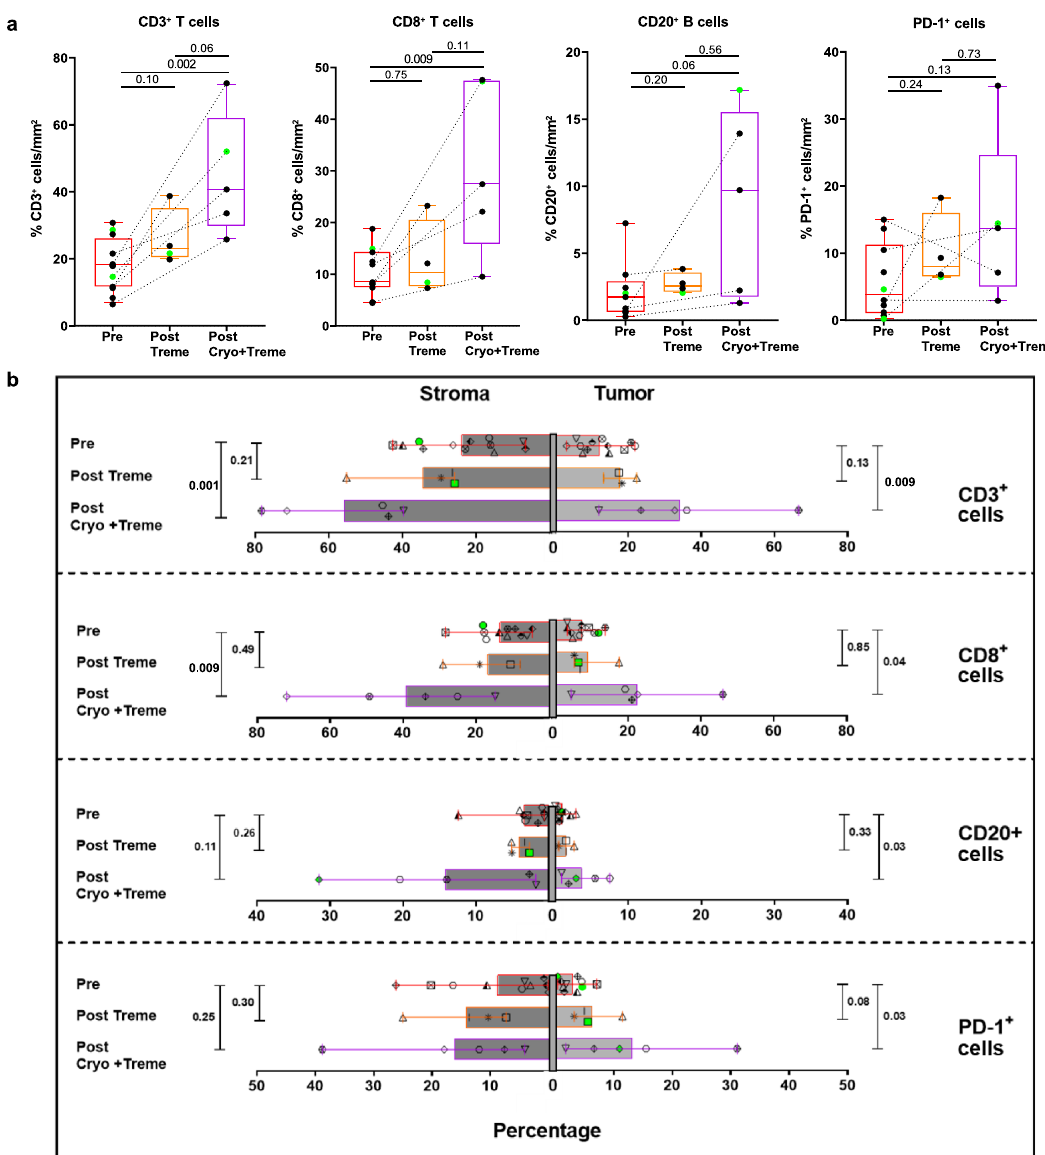
Fig. 5 Adding cryoablation to tremelimumab leads to immune cell in fi ltration in the tumor microenvironment of mRCC patients with clear cell histology. Pre- and post-treatment tissue samples from patients with clear cell histology who had evaluable tumor tissue samples were analyzed for immune cell in fi ltration by IHC. a Box plots showing in fi ltration of CD3 and CD8 T cells, CD20 + B cells, and immune cells expressing PD-1 in the tumor microenvironment of pre, (red, n = 12) and post-treatment tumor samples of patients treated with tremelimumab monotherapy (post Treme, orange, n = 4) or cryoablation plus tremelimumab combination therapy (Post Cryo + Treme, purple, n = 5). For the box plots, the ends of the box are the upper and lower quartiles (75th and 25th percentiles), the median is the horizontal line inside the box, whisker lines extend to outliers (minimum and maximum) and b Bar plots showing the preferential distribution of immune cells as in a between the tumor and stromal compartments of the tumor microenvironment. Pre shown in red, post Treme shown in orange, and Post Cryo + Treme shown in purple. Patients with ongoing responses are shown in green. Error bars represent the mean with minimum to maximum value range. P values were calculated using a two-tailed, unpaired Mann – Whitney test. P values were adjusted for multiple comparisons using the Benjamini – Hochberg procedure. P < 0.05 denotes signi fi cant differences. Pre pre-treatment sample, Post Treme , post-treatment sample treated with tremelimumab monotherapy, Post Cryo + Treme post-treatment sample treated with cryoablation plus tremelimumab combination therapy. All source data are provided as a Source Data fi